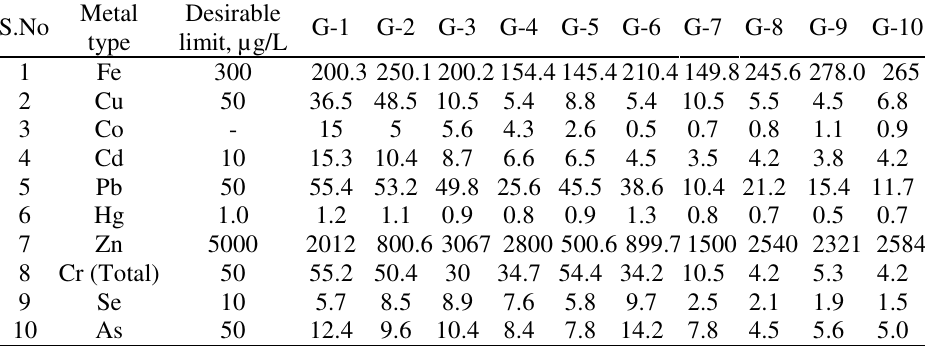
Table 4. The results of heavy metal determinations in groundwater samples.